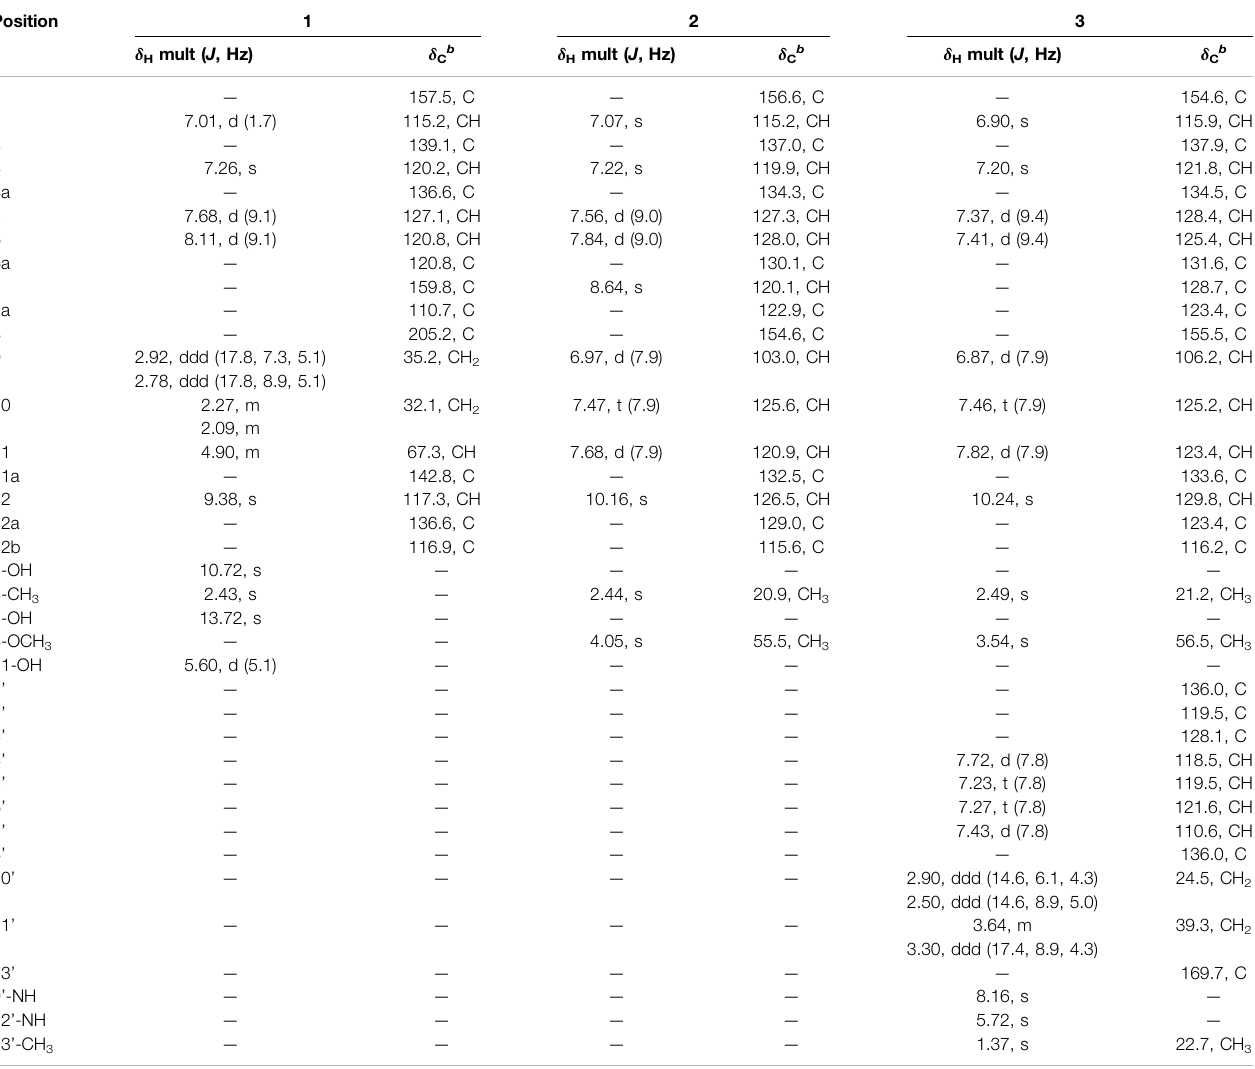
TABLE 1 | 1 H and 13 C NMR data for 1-3 in DMSO- d 6 a